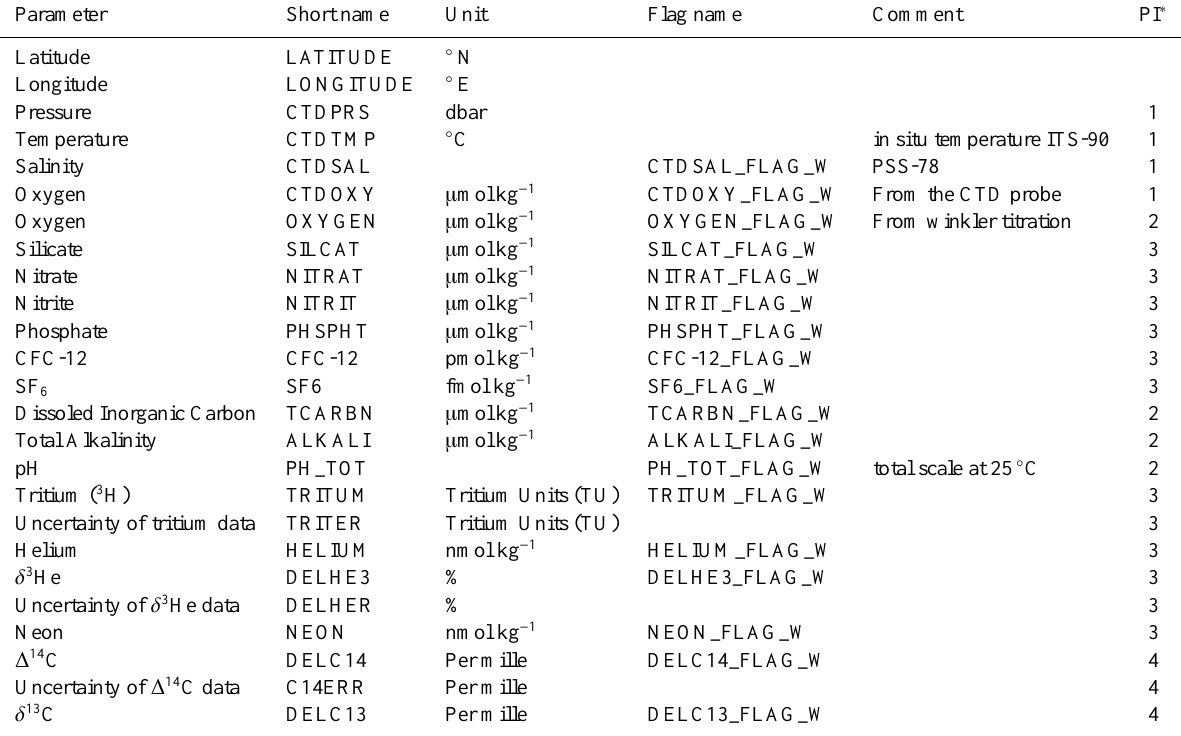
Table 1. List of variables available from the Meteor cruise M84 / 3 in 2011. The PIs listed in the last column are: (1) Dagmar Hainbucher, (2) Marta Alvarez, (3) Toste Tanhua, (4) Robert Key, Princeton University, NJ, USA and Ann McNichol, WHOI,